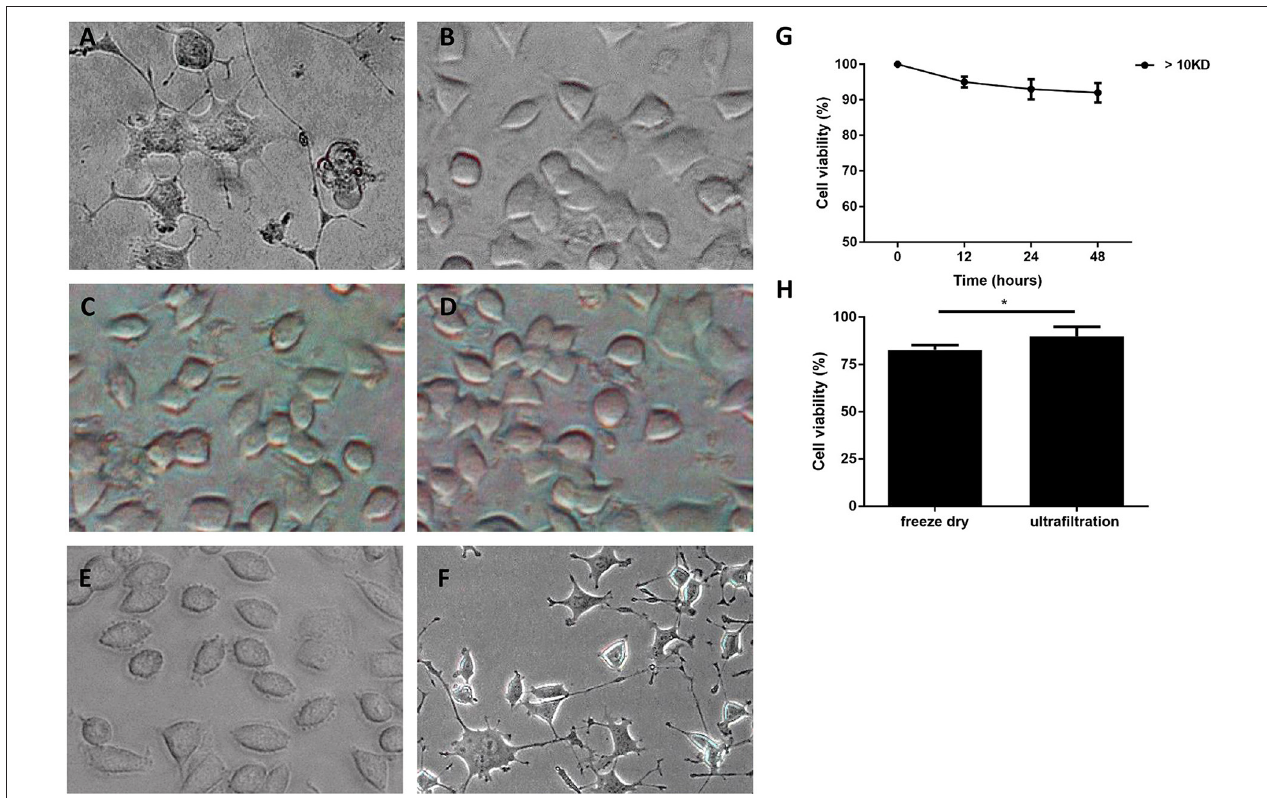
FIGURE 2 | Morphology changes of PC12 cells treated with culture supernatant of M. smegmatis . PC12 cells treated with culture supernatant of M. Smegmatis (A) , B. subtilis (B) , E. coli (C) , and heat-killed M. smegmatis (D) ; (E,F) < 10 kD and > 10 kD subgroup of live M. smegmatis culture supernatant for 48h, and cells were observed under phase-contrast microscope ( × 40). (G) Cell viability of PC12 treated with ultrafiltrated supernatant at indicated time; (H) The relative viability of cells treated by CM with freeze drying or ultrafiltration for 48h. Quantitative results were presented as means ± S.D. for 3 replicates. * P < 0.05, vs. control group, n = 3.